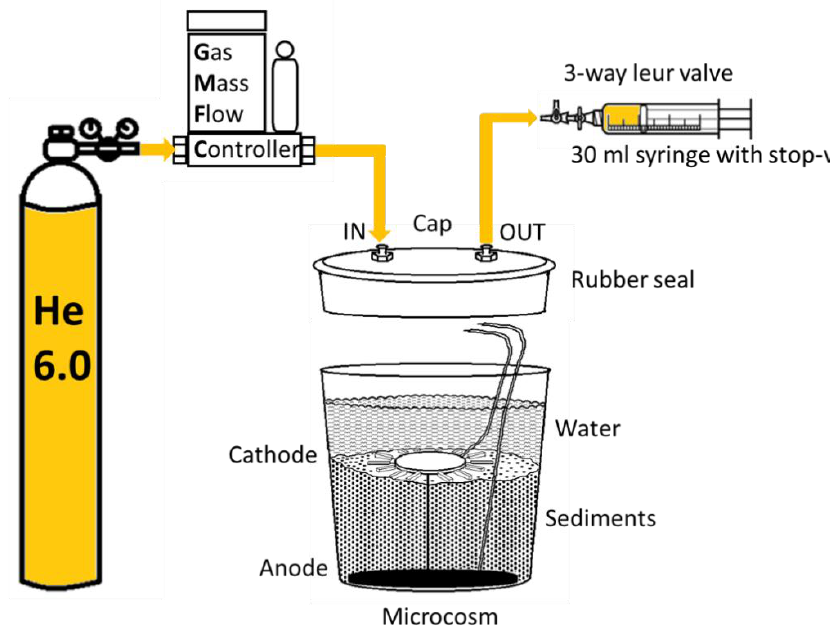
Figure 1. Schematic representation of N 2 O sampling from CW-MES (the coupling of constructed wetlands to microbial fuel cells) systems, where anode is embedded in the sediment and connected via copper connections to cathode, which rest on the